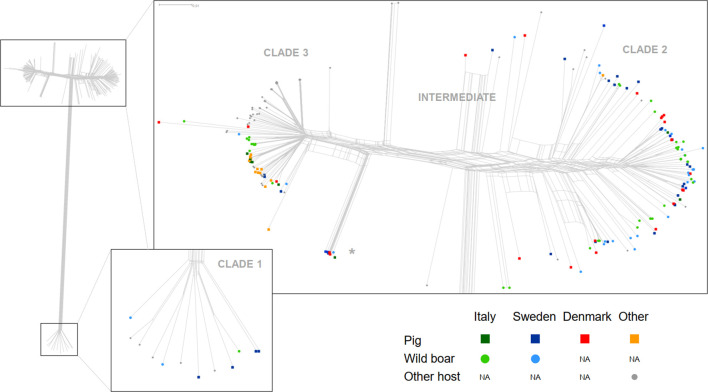
NeighborNet representation of SNP variation among isolates of ER from pigs and boars from Italy, Sweden, Denmark and other countries (n=158) and isolates from other hosts including wild and domestic animals (n=85). Left side: overview; right side upper panel: detail of clades 2, 3 and intermediate with pig/wild boar isolates highlighted; right side lower panel: detail of clade 1 with pig/wild boar isolates highlighted. A clade consisting of only pig and boar isolates discussed in the main text is marked with an asterisk.